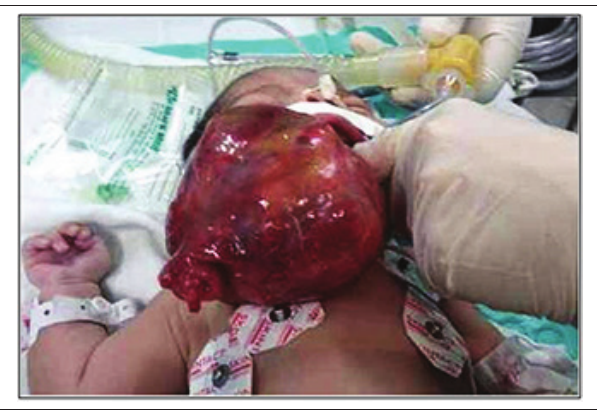
figuRE 2 − Aspect at birth Presence of a voluminous mass arising from the oral cavity.